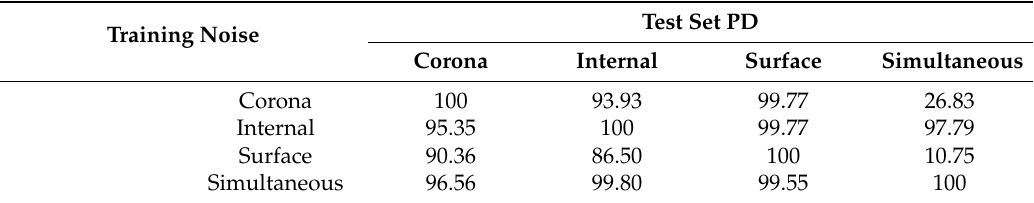
Table 2. Classification efficiency (%) of the OCSVM detecting background noise of different PD